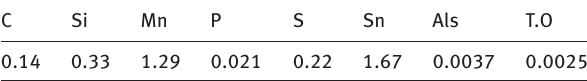
Table 1: Chemical composition in mass%